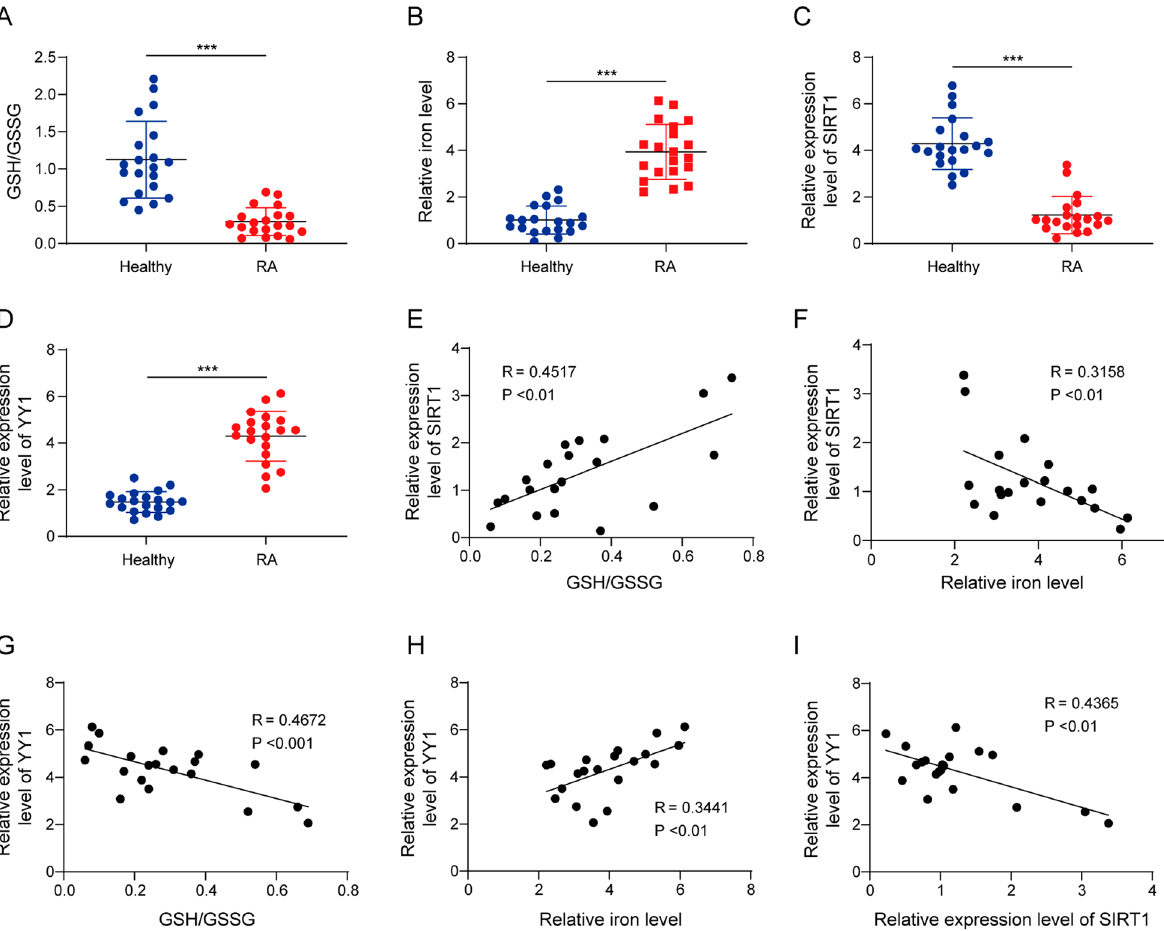
Fig. 1 RA was associated with ferroptosis and the differential expressions of YY1 and SIRT1. A GSH/GSSG in the serum of healthy volunteers and RA patients were examined by GSH/GSSG assay. B Iron levels in the serum of healthy volunteers and RA patients were examined by iron assay. C SIRT1 expression in the serum of healthy volunteers and RA patients was examined by qPCR. D YY1 expression in the serum of healthy volunteers and RA patients was examined by qPCR. E , F The correlation between SIRT1 and GSH/GSSG, iron level in RA. G , H The correlation between YY1 and GSH/ GSSG, iron level in RA. I The correlation between YY1 and SIRT1 in RA. N 20, mean SD, * **p < = ±